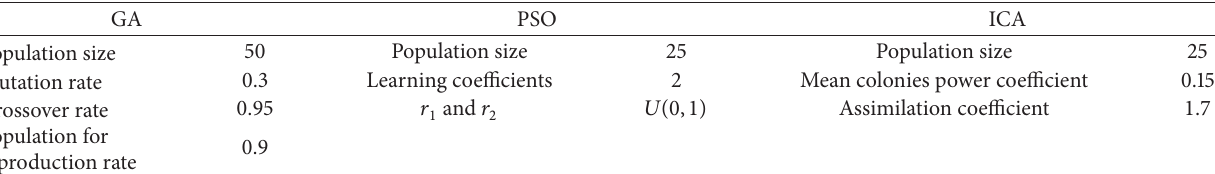
Table 2: Optimal parameter values for ICA, PSO, and GA algorithms which maximize the output SNR. GA